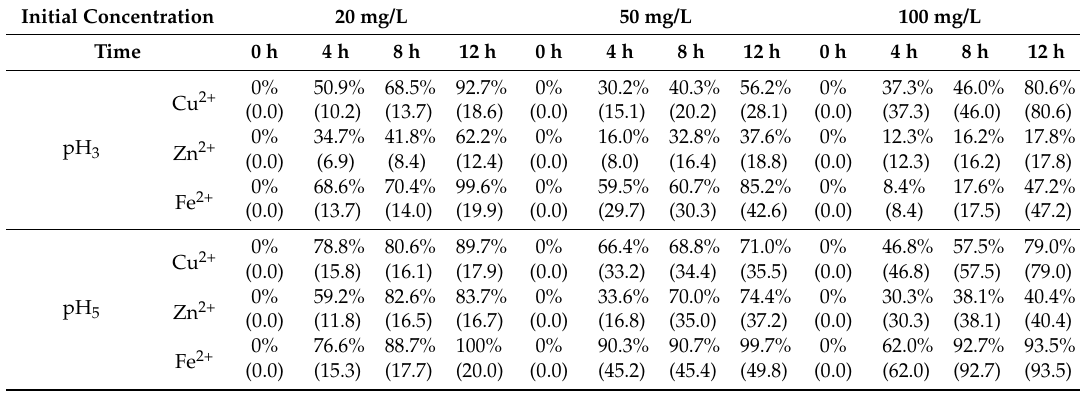
Table 1. Copper, zinc and iron removal from AAD by the microalga Muriellopsis sp., cultivated in SSM (35%), different pHs and metal concentrations. Values in parentheses are in mg/L. Initial